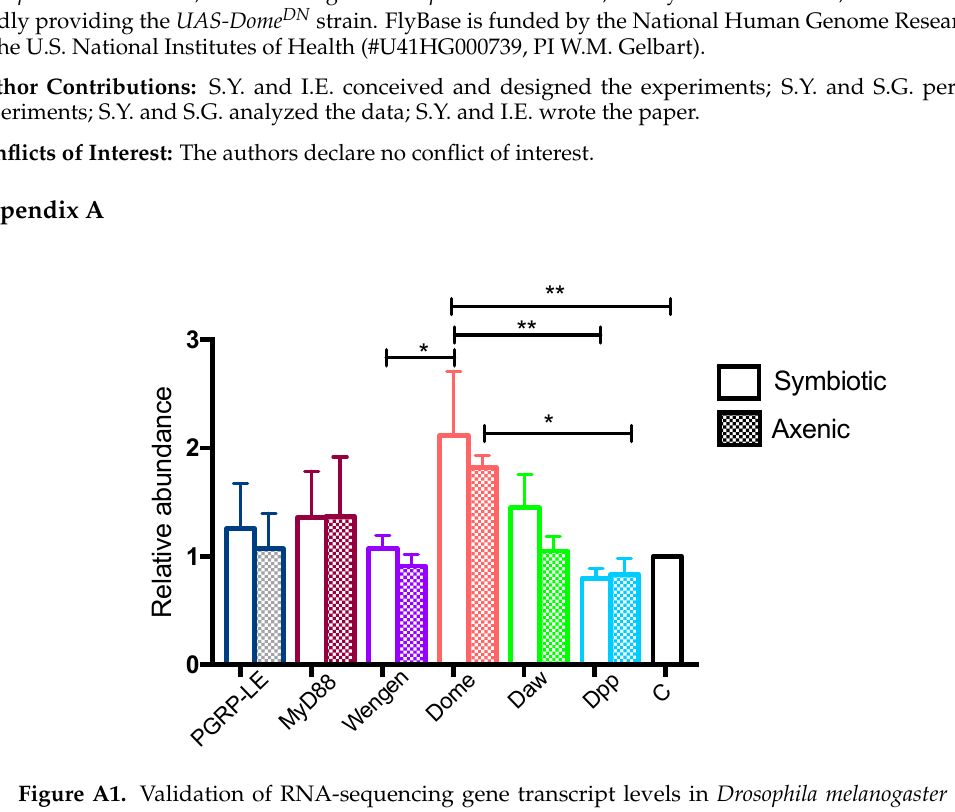
Figure A1. Validation of RNA-sequencing gene transcript levels in Drosophila melanogaster larvae infected with Steinernema carpocapsae symbiotic or axenic nematodes using qRT-PCR. Relative transcript levels of PGRP-LE , MyD88 , Wengen , Domeless , Dawdle , and Decapentaplegic genes in D. melanogaster larvae infected with symbiotic or axenic S. carpocapsae nematodes at 24 h post-infection. Transcript levels are shown as relative abundance normalized to the housekeeping RpL32 gene and expressed as a ratio compared to the uninfected control larvae for each strain. Values of uninfected control (C) samples are set to one. Values represent means from four biological replicates and error bars represent standard deviations. Data were analyzed using one-way analysis of variance (ANOVA) and a Tukey post-hoc test for multiple comparisons using GraphPad Prism 7 software. * p < 0.05, ** p < 0.01, *** p < 0.001. Non-significant differences ( p > 0.05) are not shown.